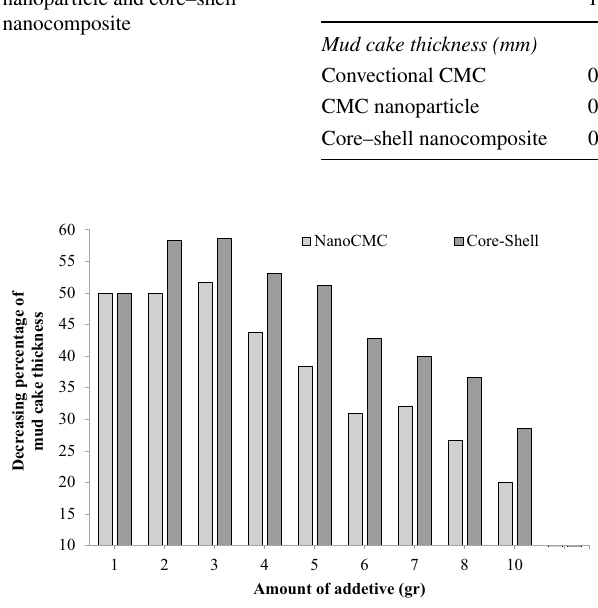
Fig. 8 Comparison of mud cake thickness resulted from addition of nanoCMC and core–shell nanocomposite (compared to bulk CMC)